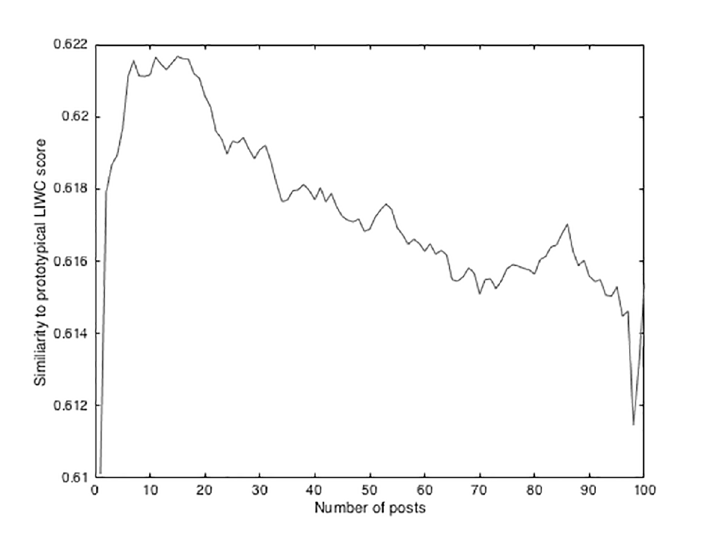
Figure 2. Deviance of posts to the content of forum as a function of the time spent on the forum, n = 11751. Note . The y-axis represents deviations between posts presented at a certain time and all posts. Each LIWC score was first z-transformed, so that each LIWC score had mean of zero and standard deviation of one. Deviations from the normal scores are then calculated as the absolute values of summed over all LIWC scores. The data is smoothed over 20 time